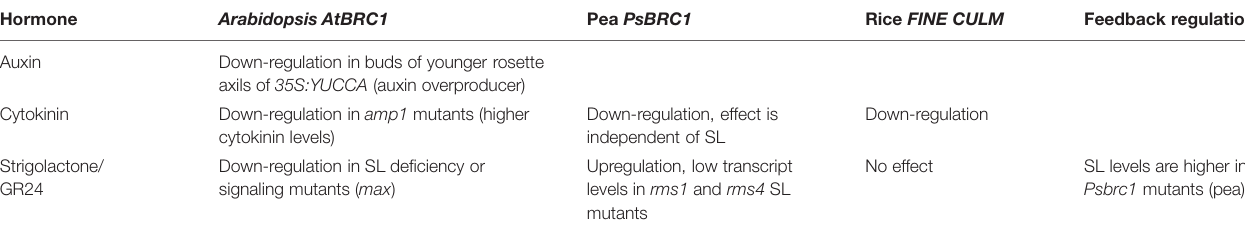
TABLE 2 | Regulation of BRC1 / TB1 expression. Hormone Arabidopsis